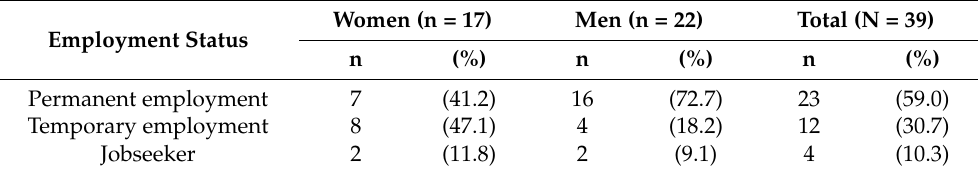
Table 1. Description of the work situation of the PhD alumni (N = 39) from the Norwegian Research School of Global Health.